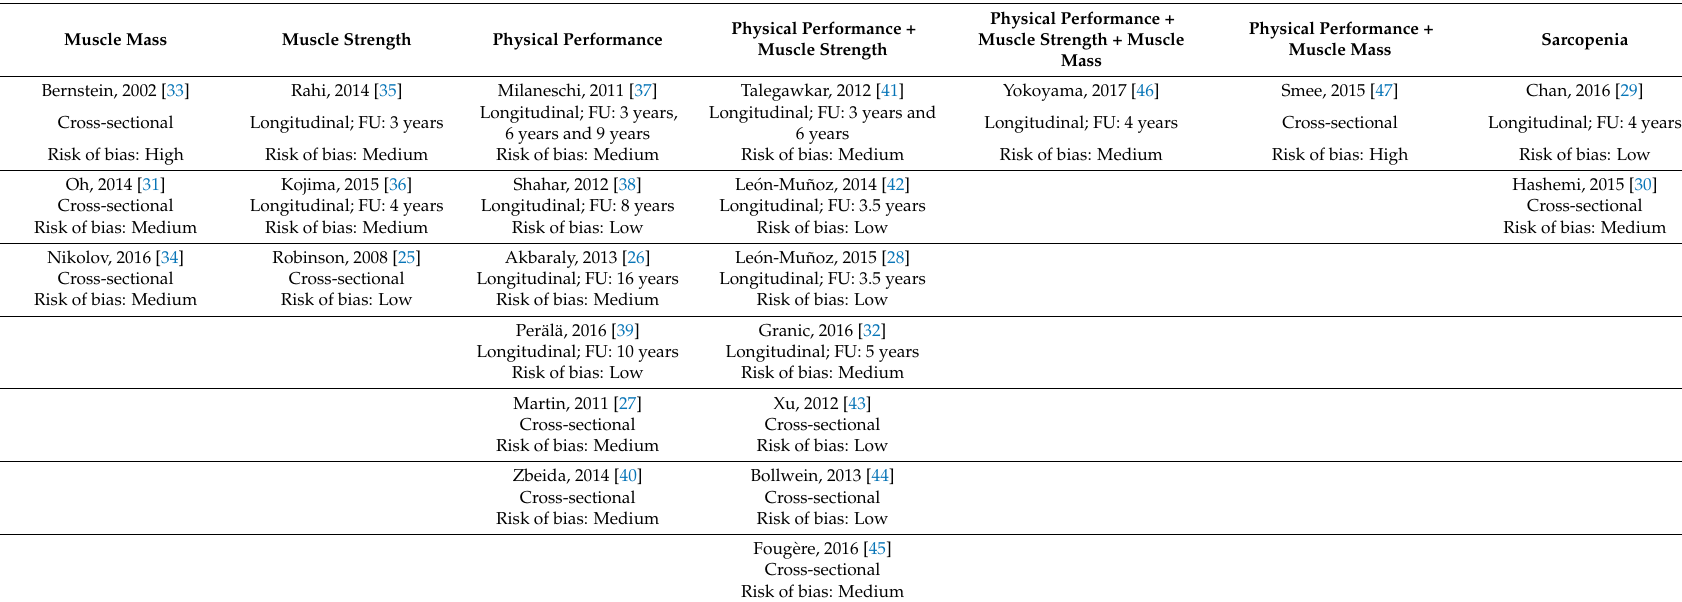
Table 2. Summary of systematic review studies by